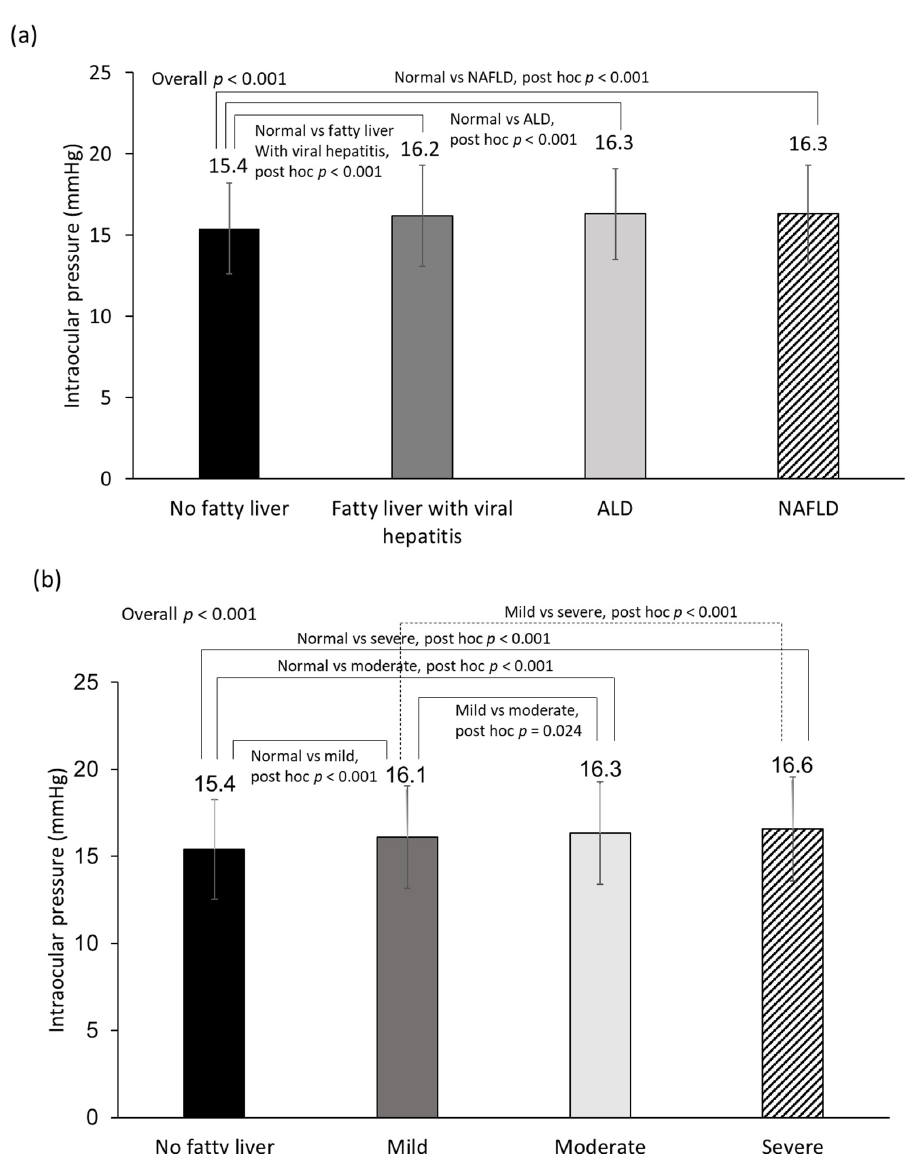
Figure 2. Comparison of mean intraocular pressure level according to the etiology of fatty liver ( a ) and the severity of fatty liver ( b ). Abbreviations: ALD, alcoholic liver disease; NAFLD, nonalcoholic fatty liver disease. Analysis of variance was performed to compare differences in intraocular pressure among groups. Post hoc analysis was performed with Bonferroni correction. p < 0.05 was considered statistically significant.